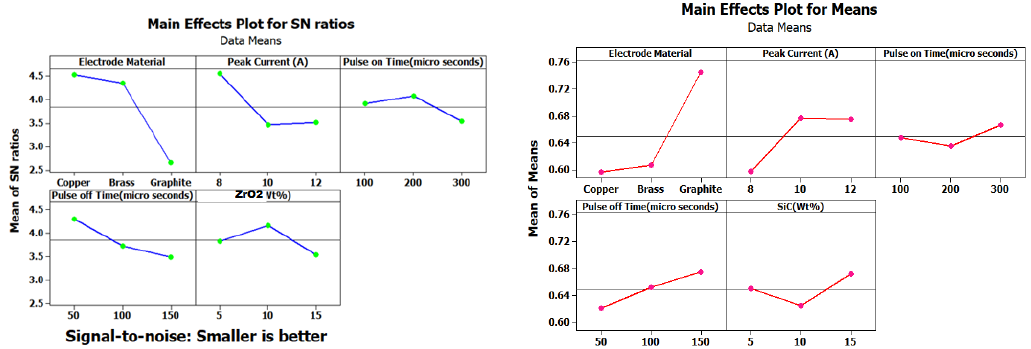
Figure 28. Variation of EWR (mm 3 /min) under different machining conditions.